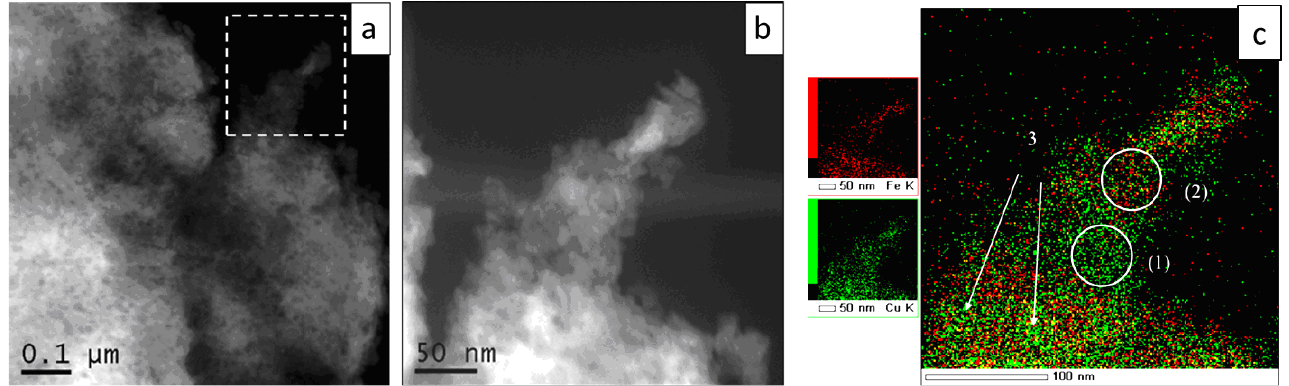
Figure 6. ( a ) STEM-HAADF image of a Cu+Fe aggregate (90 min of milling), ( b ) a higher magnification image, ( c ) superposition of the EDX maps for the area shown in ( b ): (1) Cu – rich areas, (2) Fe-rich areas, (3) layers of iron between copper particles. Table 4. The atomic concentration of elements in the Cu+Fe mixture after 90 min of milling from regions shown in Figure